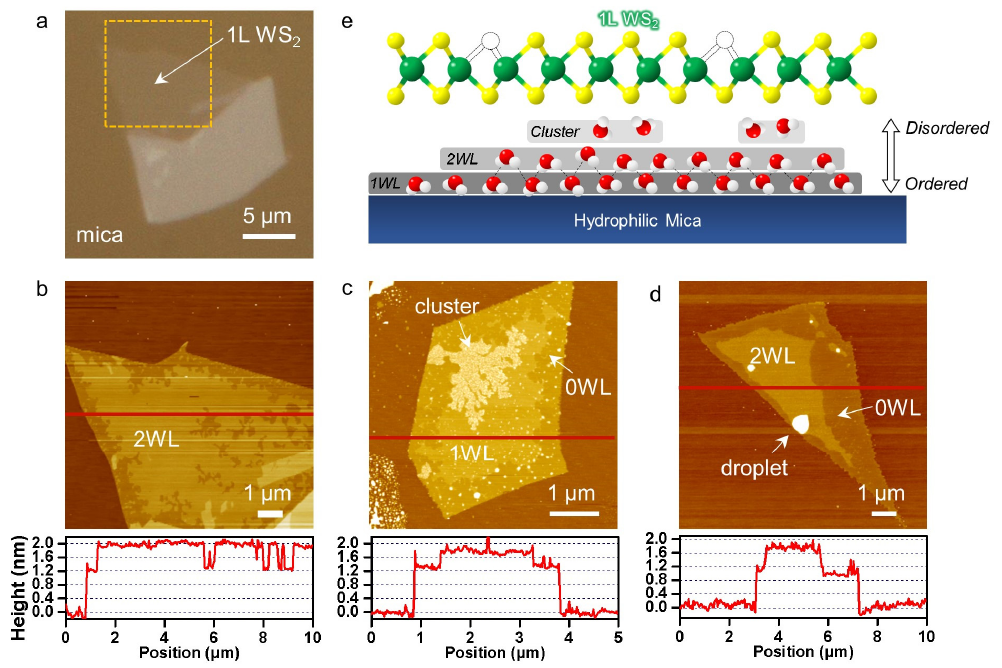
Figure 1. Morphology of the interfacial water layers. ( a , b ) Optical micrograph ( a ) and AFM height image and profile ( b ) of 1L WS 2 on mica. The AFM image showing 2L interfacial water (2WL) was obtained from the orange square in ( a ). The height profile in ( b ) was taken along the red line in ( b ). ( c , d ) AFM images and height profiles of two additional samples containing various forms of interfacial water. ( e ) Scheme of 1L WS 2 /water/mica.